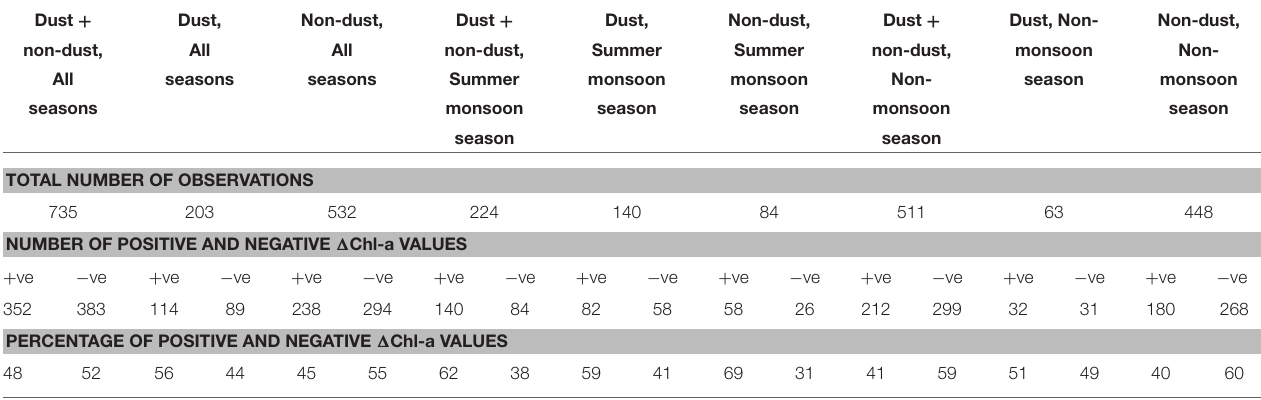
TABLE 2 | The number of observations with enhancements in Chl-a ( + ve 1 Chl-a) or reductions in Chl-a ( − ve 1 Chl-a), for all data, and for the summer monsoon, for the non-monsoon and sorted according to whether the aerosols were identified as dust or not (here, dust aerosols were derived from NASA-AOT